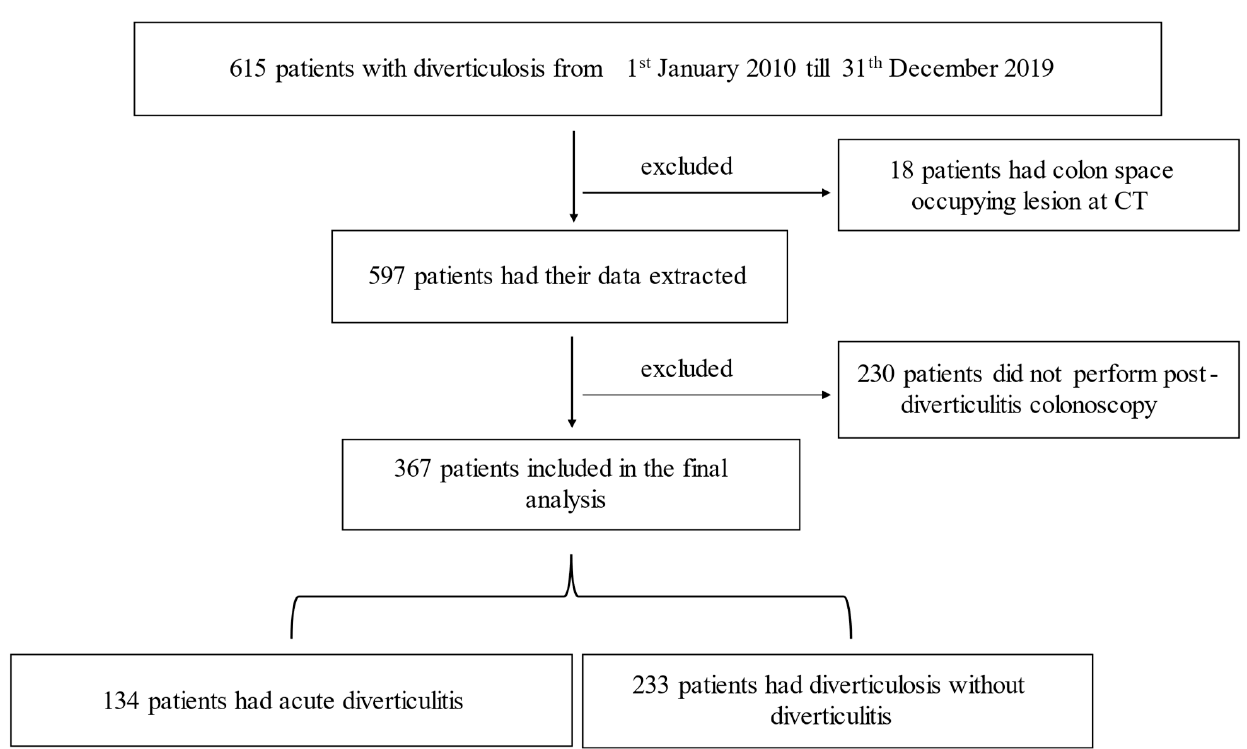
Figure 1. Demonstrate the flow chart of the study cohort.